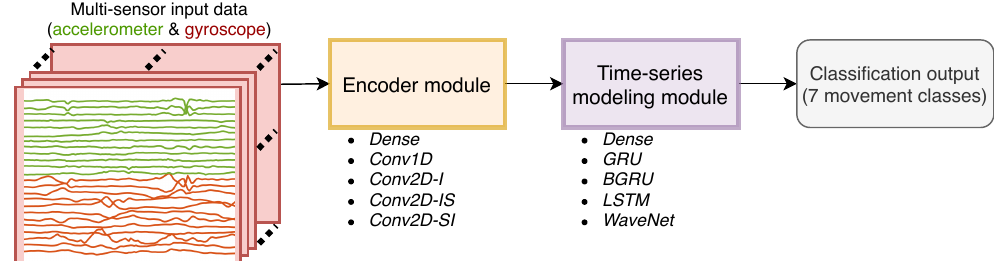
Figure 2. Overall schematic of the compared classifier